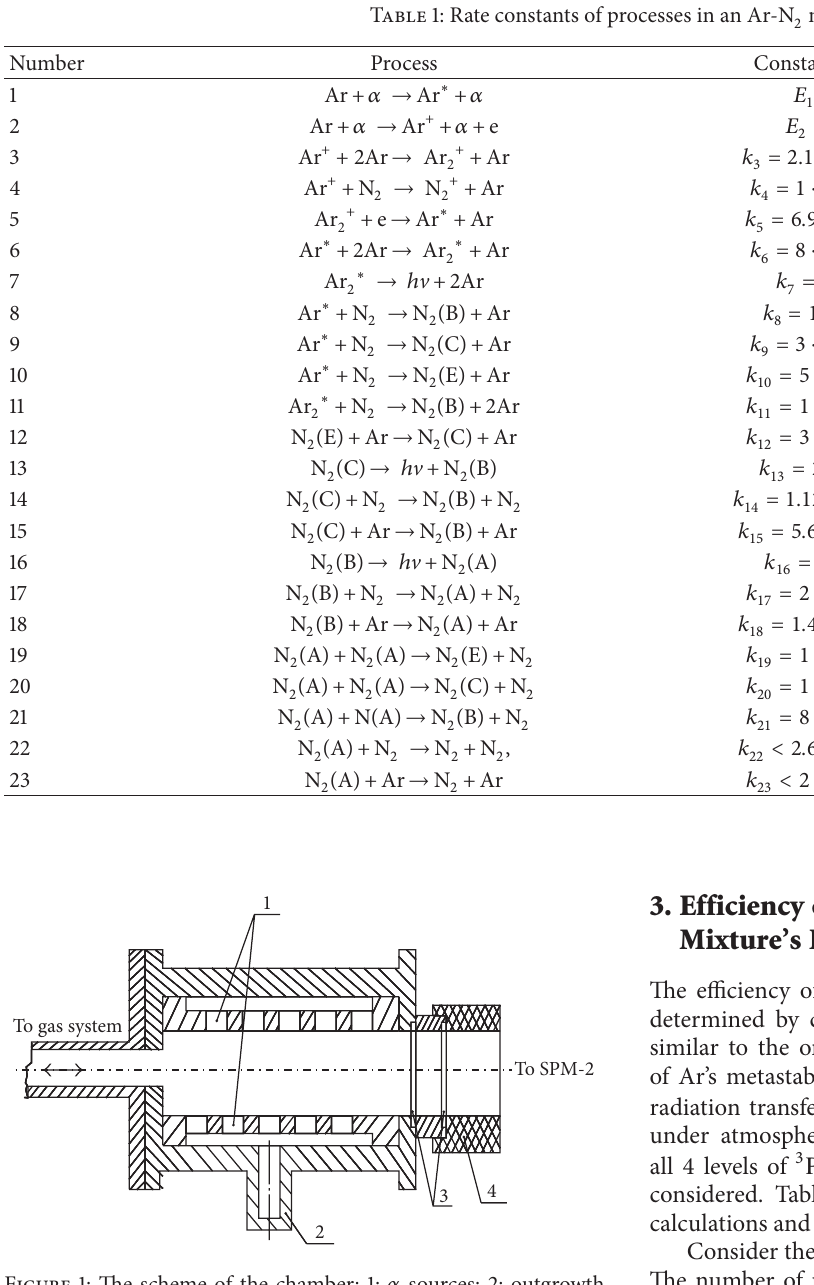
Figure 1: The scheme of the chamber: 1: 𝛼 -sources; 2: outgrowth with mercury; 3: windows; 4: